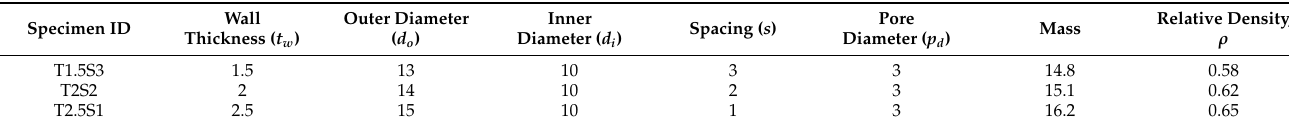
Table 2. Specifications of the biomimetic structures (units: mm and g).